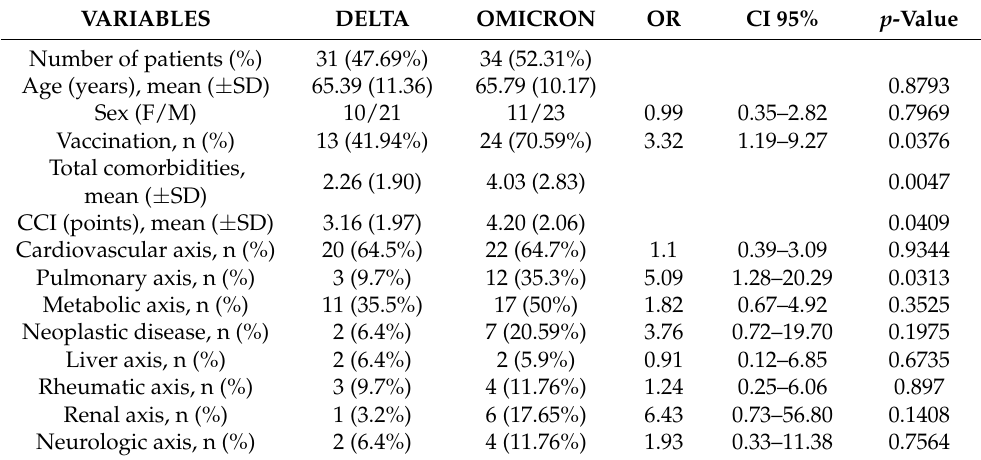
Table 1. Demographic data, vaccination status, and pre-existing comorbidities of patients belonging to Delta and Omicron groups on ICU COVID-19 admission. Values are means ( ± S.D.) or number (%). OR: odds ratio; CI: confidence interval.